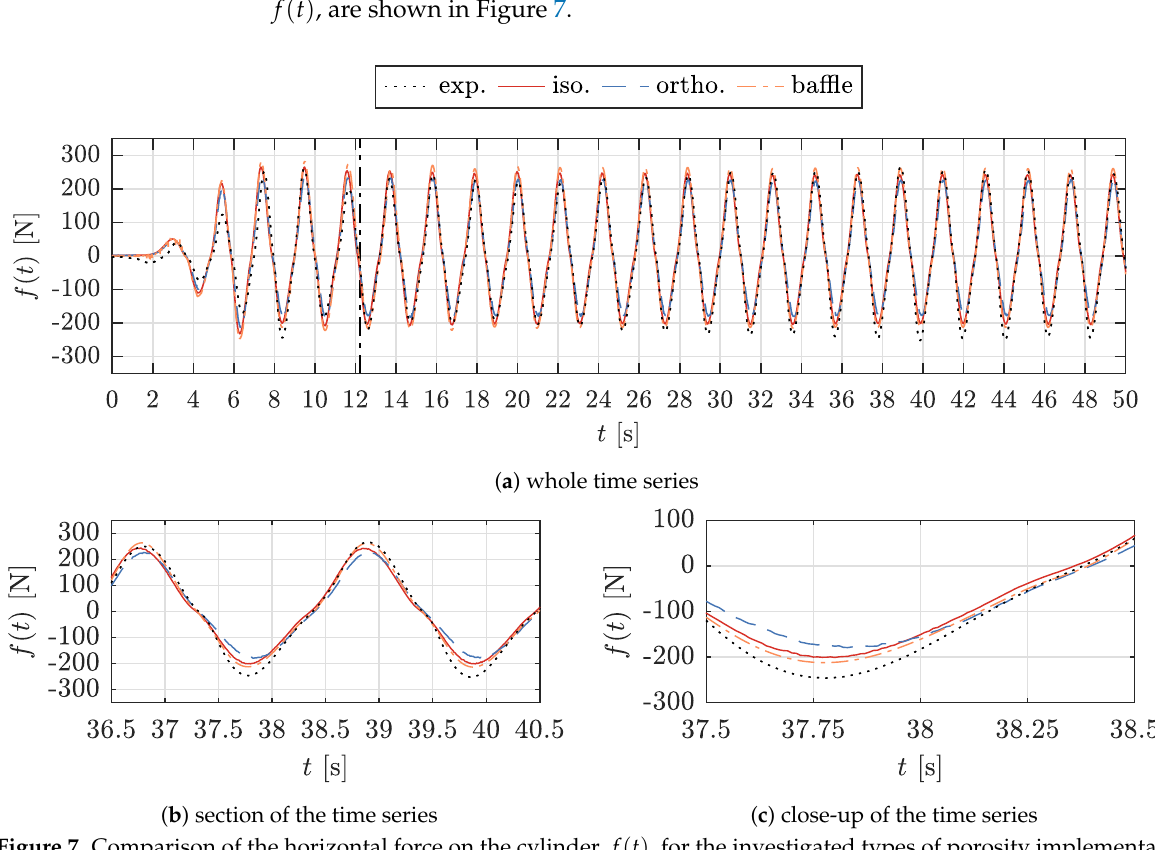
Figure 7. Comparison of the horizontal force on the cylinder, f ( t ) , for the investigated types of porosity implementation. ( a ) whole time series ( b ) section of the time series ( c ) close-up of the time